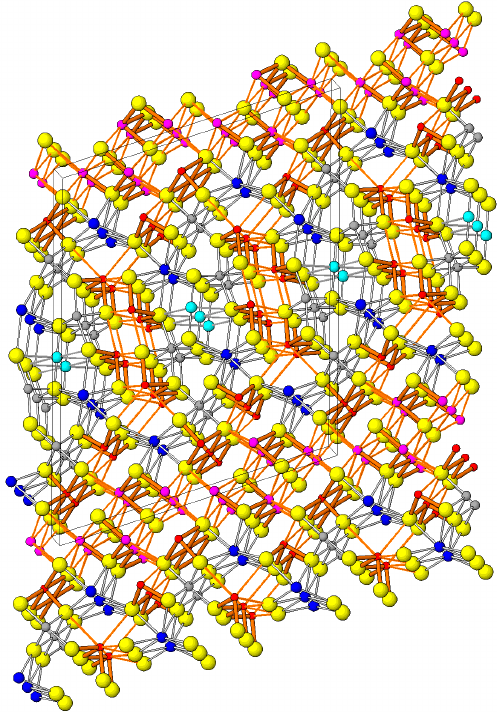
Figure 3. Crystal structure of tsygankoite in projection onto (010). Yellow spheres: S; blue spheres: Tl; turquoise: Hg; red: Sb and (Sb,As); mauve: (Sb,Pb,Tl); grey: Mn. Short, strong Sb–S bonds: thick orange lines, longer distances: thin lines. Remaining cation–anion connections: bonds and distances defining the complete coordination polyhedron. The c direction is upward oriented; inclined slightly.